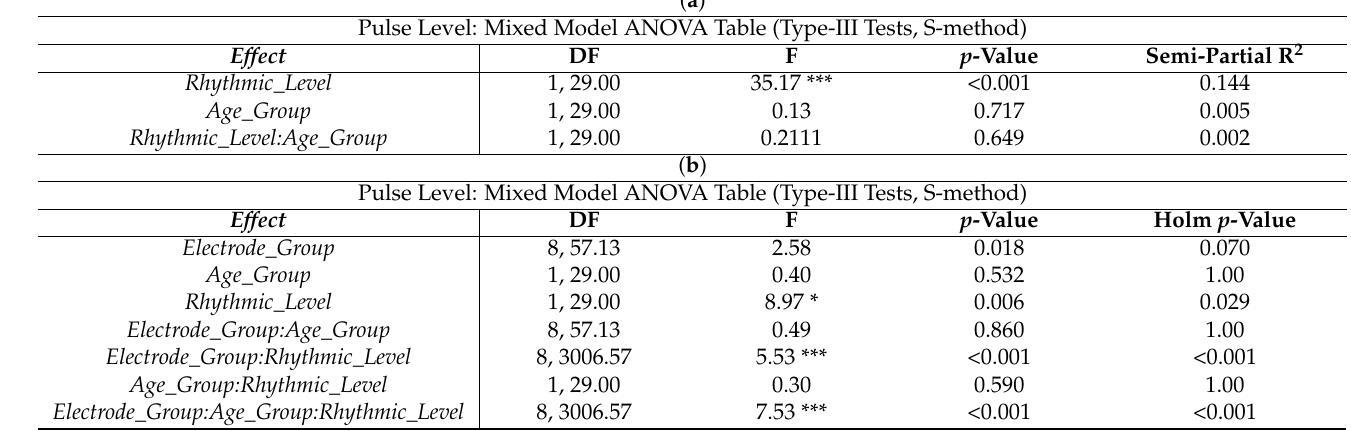
Table 3. ( a ) Pulse level—ANOVA Table. For the pulse level, a linear-mixed effect model returned a significant main effect for rhythmic level (e.g., pulse level, off-pulse level) on phase-locking values (PLV) to music. ( b ) Pulse Level—ANOVA Table. For the pulse level, a linear-mixed effect model returned a significant three-way interaction between electrode group*rhythmic level*age group fixed effects on phase-locking values (PLV) to music. ( a ) Pulse Level: Mixed Model ANOVA Table (Type-III Tests, S-method)